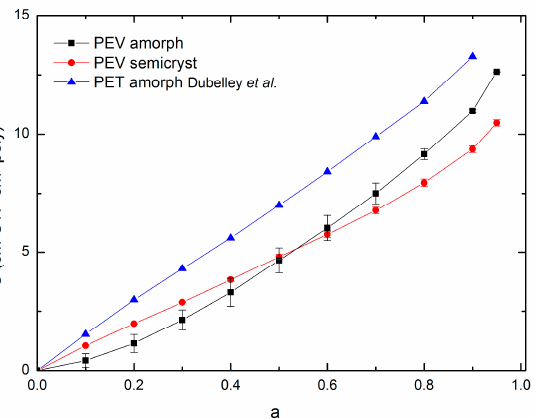
Figure 5. Water vapor sorption isotherms of amorphous and semicrystalline poly(ethylene vanillate) (PEV) at 20 °C (two replicates for each point). Water vapor sorption isotherm of amorphous PET at 23 °C from the study of Dubelley et al. [10] Lines are drawn to aid the eye and do not repre- sents model fits.